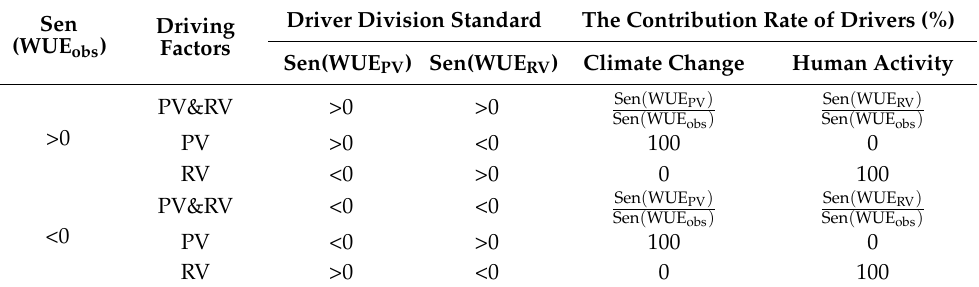
Table 1. Standards for identifying the main drivers of WUE change and methods for calculating contribution